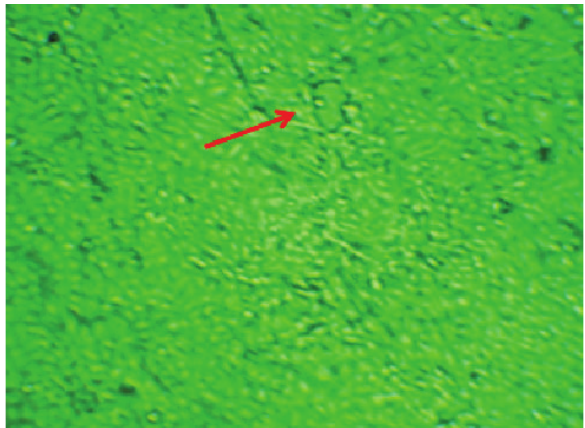
Figura 7. Cultura MDBK inoculadas com embrião do grupo G ( Punica granatum ) com “discreto efeito citopático” (seta) 4 (100x, 4,1x zoom)